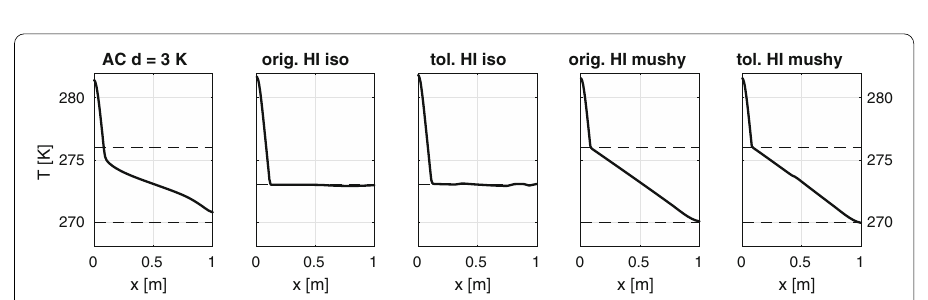
Fig. 9 Melting volume example: temperature profiles at t f obtained with five different methods for latent heat. 100 elements, (cid:11) t = 200s